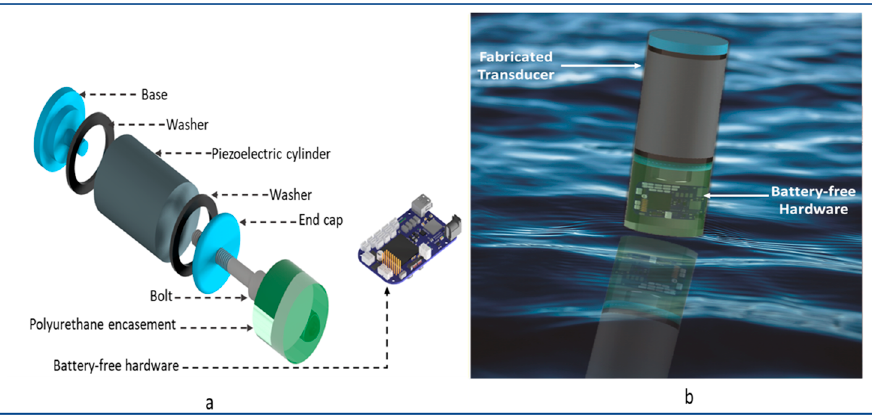
Figure 6. ( a ) Model of battery-free sensor nodes. ( b ) Design of piezoelectric sensor nodes invented by Massachusetts Institute of Technology (MIT), navigation system powered by sound [25].